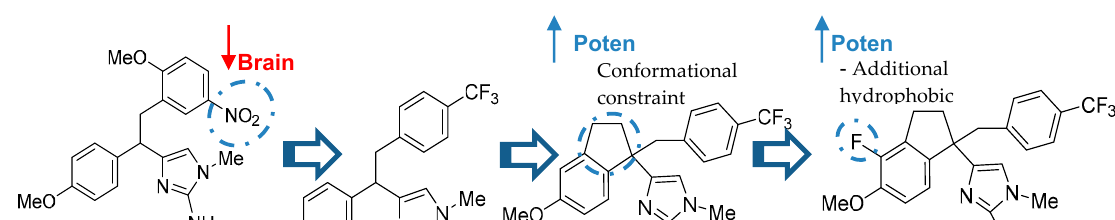
Figure 29. Merck’s aminoimidazole HTS hit.